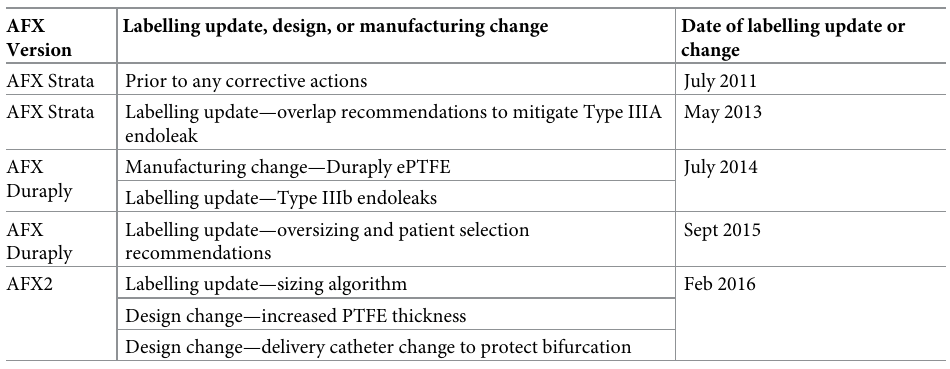
Table documenting the versions of the AFX family of endografts, the labelling updates, design and manufacturing changes with associated